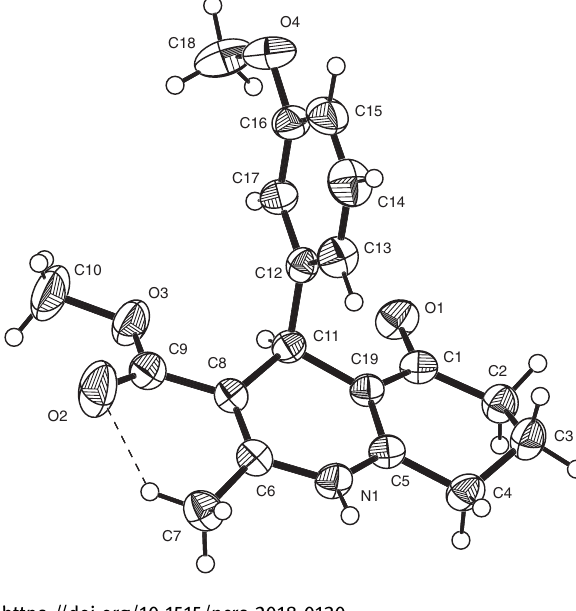
Table 1: Data collection and handling.